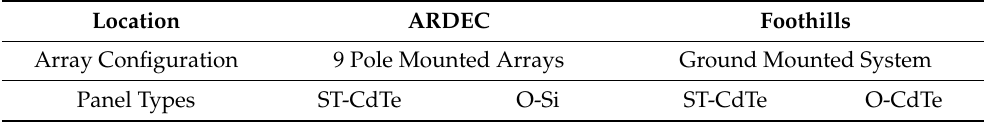
Table 1. Location, array configuration, and panel types for both sites. Location ARDEC Foothills Array Configuration 9 Pole Mounted Arrays Ground Mounted System Panel Types ST-CdTe O-Si ST-CdTe